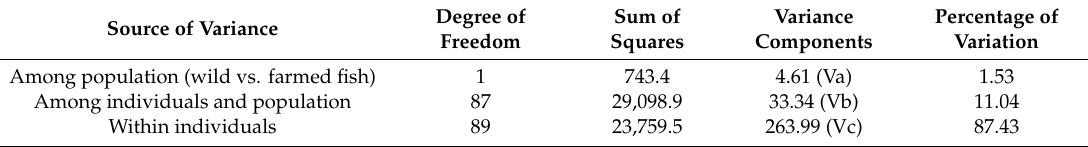
Table 2. Results of analysis of molecular